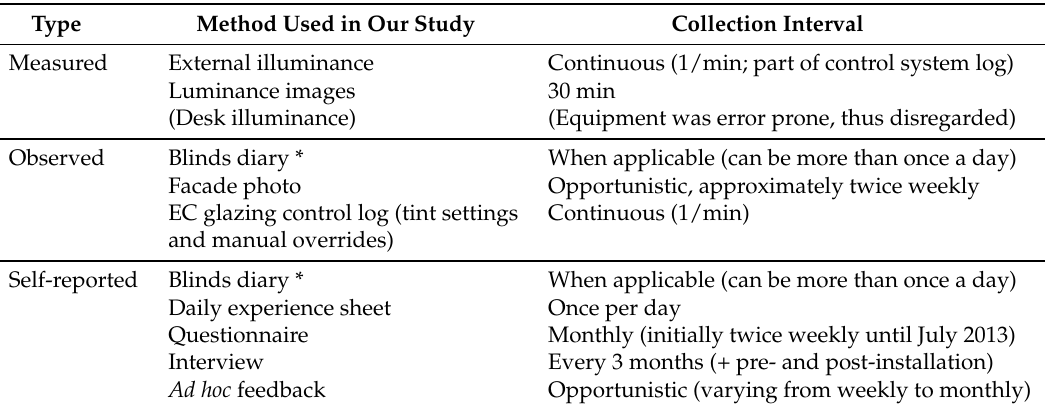
Table 2. Overview of the data collection methods used in the case study, showing the types of tools used and the timing and frequency of their application (* the blinds diary is considered both “observed” and “self-reported”; although the action is self-reported by participants, the diary records an action, thereby providing information on occupant